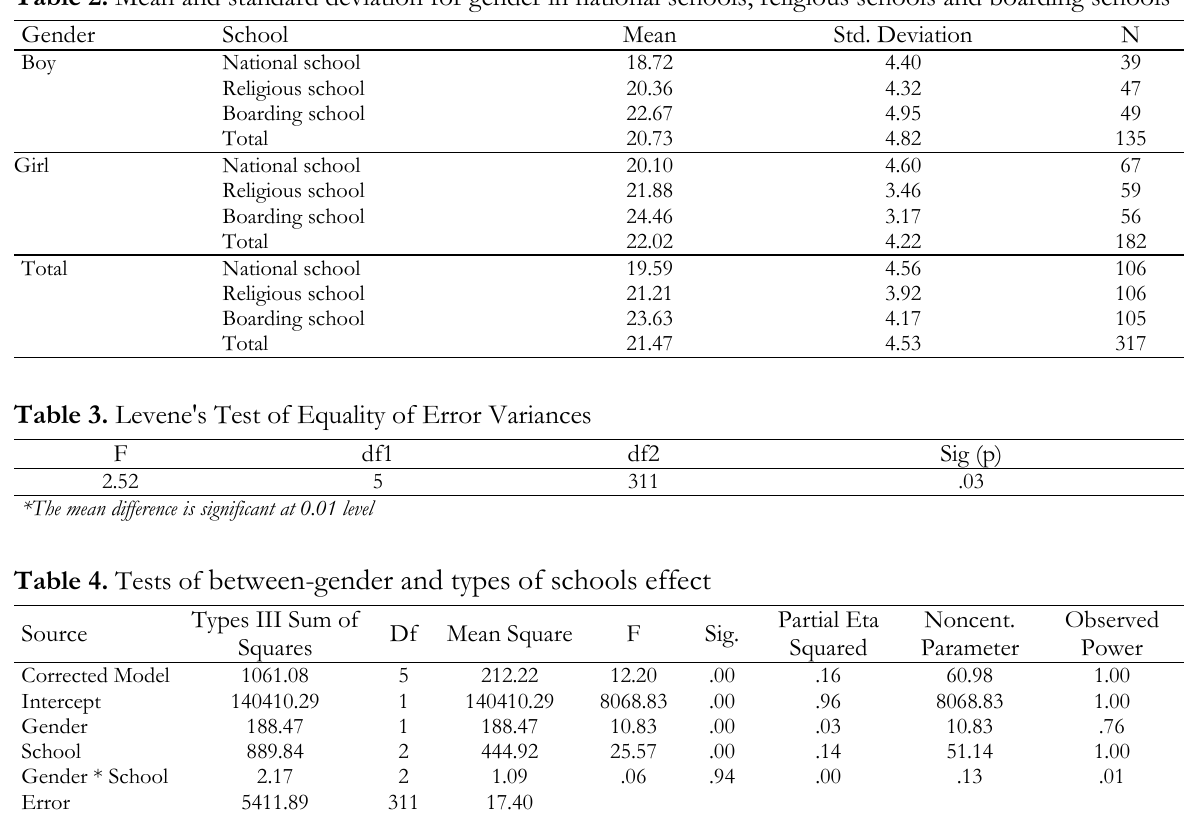
Table 2. Mean and standard deviation for gender in national schools, religious schools and boarding schools Gender School